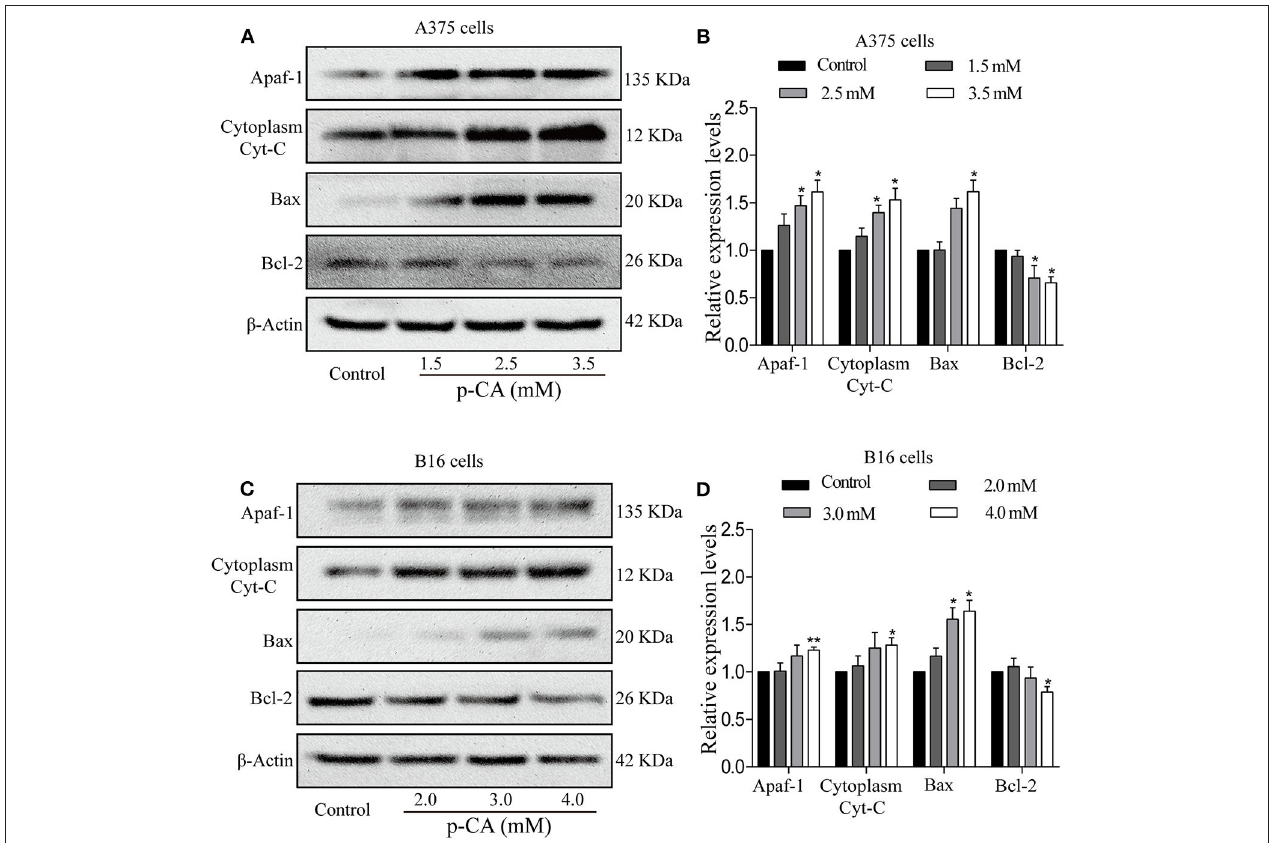
FIGURE 6 | p- CA induces A375 and B16 cell apoptosis through the Bcl-2/Bax signaling pathway. (A) The protein levels of Apaf1, cytoplasmic Cyto-C, Bax, and Bcl-2 in A375 cells treated with p- CA were measured by western blot. (B) Statistical analysis of the relative protein levels of Apaf1, cytoplasmic Cyto-C, Bax, and Bcl-2 in A375 cells treated with p- CA. The ratio of protein levels was normalized according to the value of the control. (C) The protein levels of Apaf1, cytoplasmic Cyto-C, Bax, and Bcl-2 in B16 cells treated with p- CA were measured by western blot. (D) Statistical analysis of the relative protein levels of Apaf1, cytoplasmic Cyto-C, Bax, and Bcl-2 in B16 cells treated with p- CA. The ratio of protein levels was normalized according to the value of the control. All data are expressed as the mean ± SD of three independent experiments. * P < 0.05, ** P < 0.01 compared with the corresponding